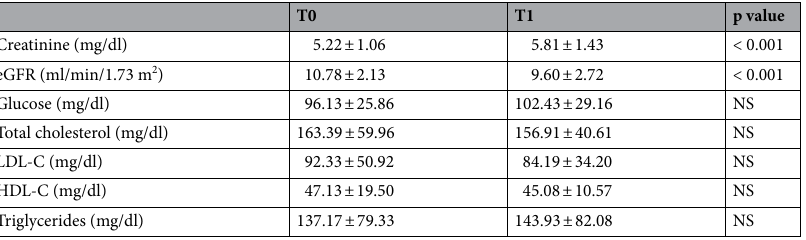
Table 1. Analytical variables at baseline (T0) and 6-month onset of CAPD (T1). eGFR estimated glomerular filtration rate, LDL-C low-density lipoprotein cholesterol, HDL high-density lipoprotein cholesterol, NS statistically